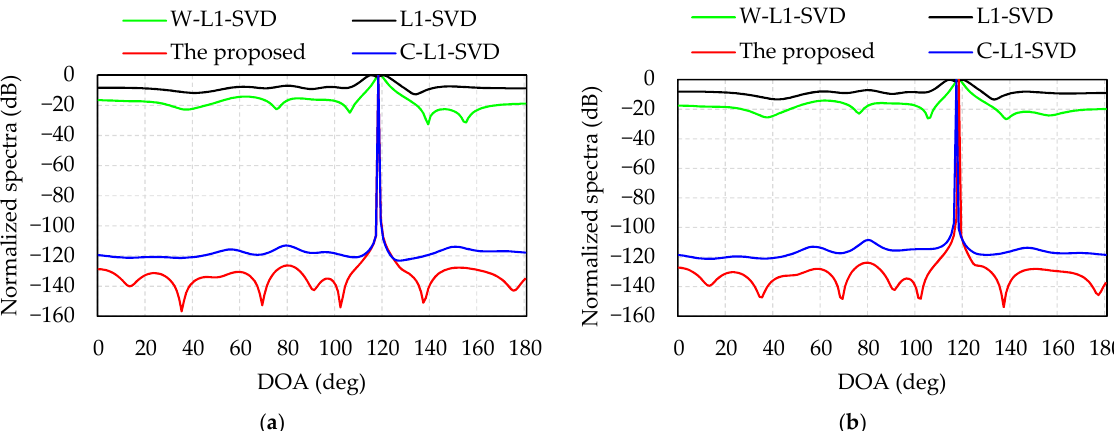
Figure 9. Normalized spectra during the measurement of outdoor scenario when the incident angle is 117.2°: ( a ) the SNR of emission signal is 0 dB; ( b ) the SNR of emission signal is 15 dB.